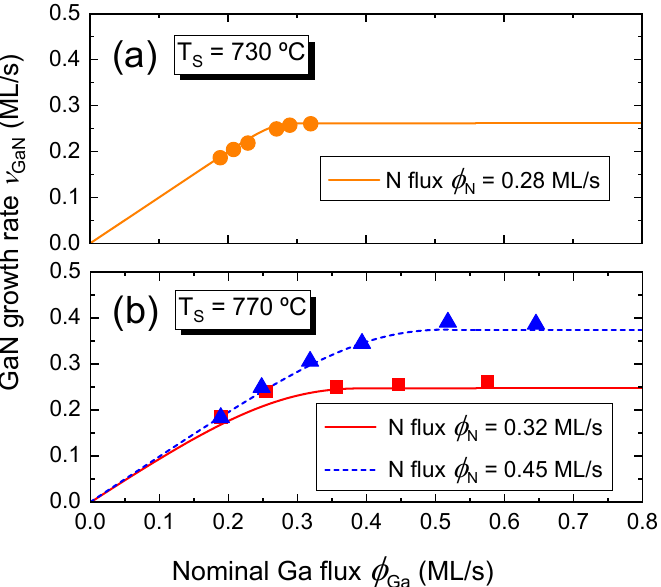
Figure A1. Growth rate of GaN as a function of the impinging Ga flux, for two substrate temperatures and two impinging N fluxes. The dots of ( a , b ) are experimental data taken from Refs. [20,53], respectively. The lines represent fits calculated within the framework of the model described in the